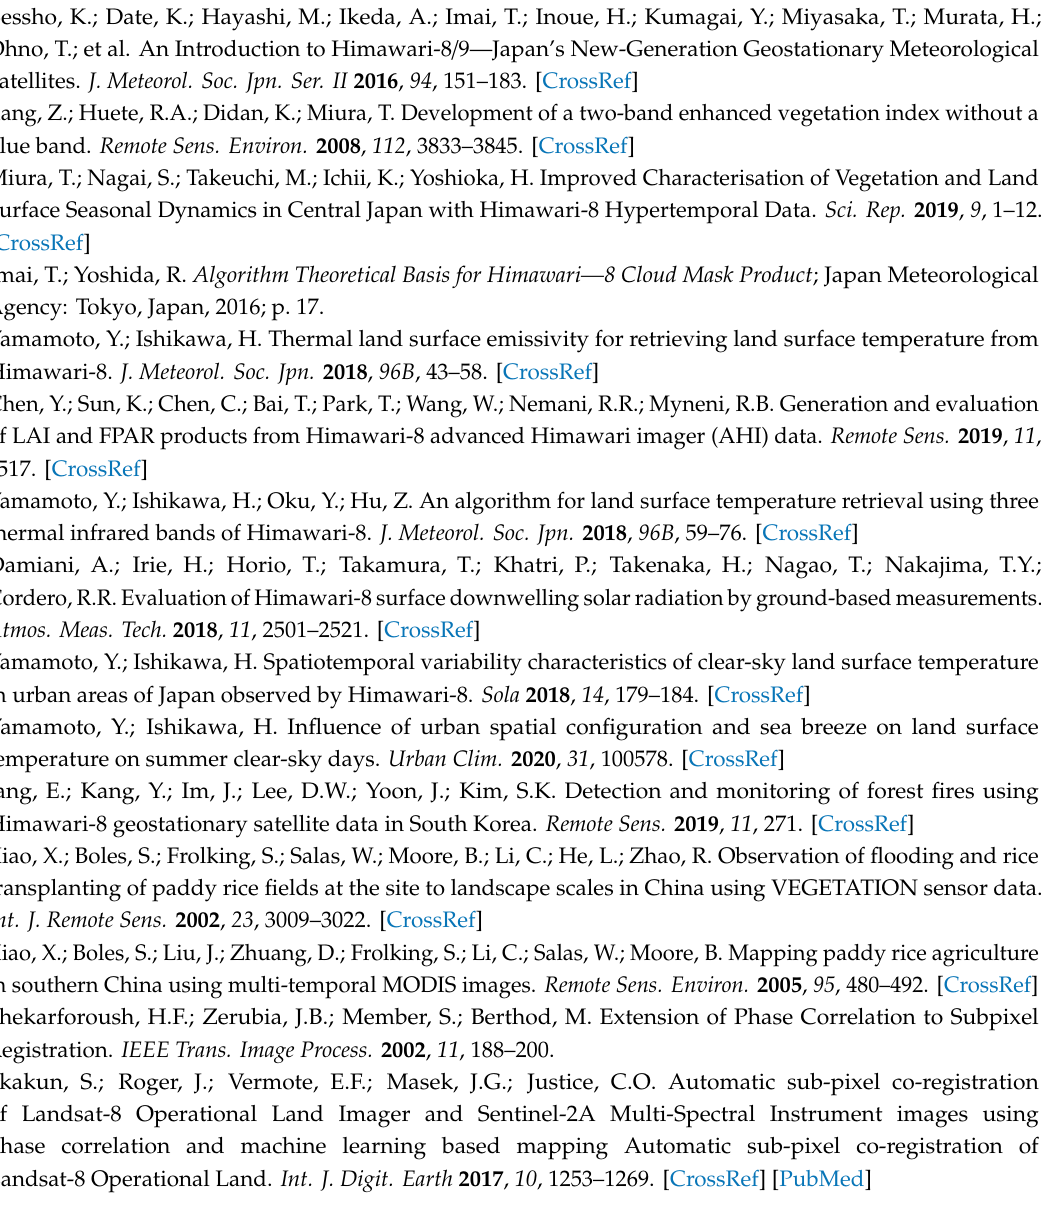
Figure S1: Results of the stability evaluation in 12 sites other than the 3 sites shown in Figure 7. Upper left-hand: time series of R obs_CEReS , R obs_JMA , and R ref . Upper right-hand: histogram of R obs_CEReS – R ref (red) and R obs_JMA – R ref (blue). Lower left-hand: similar to the upper left-hand but for σ R obs_CEReS , σ R obs_JMA , and σ R ref . Lower right-hand: similar to the upper right-hand but for σ R obs_CEReS – σ R ref (red) and σ R obs_JMA – σ R ref